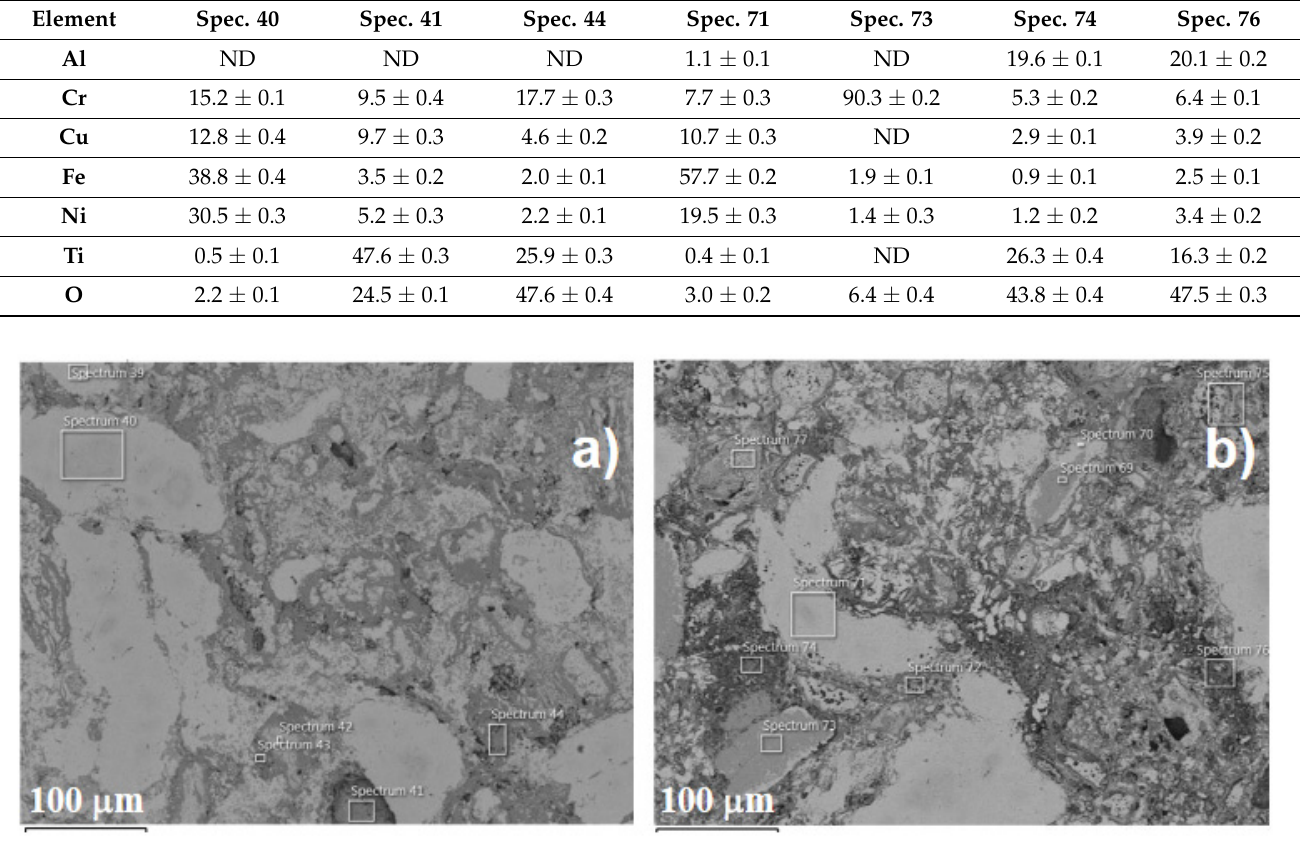
Figure 4. SEM-BSE micrographs and studied zones of x = 0 ( a ) and 5% ( b ) Al samples. Table 2. Summary chart with chemical analyses (in at. % & deviation) of spectrum shown in Figure 4 (ND = non-detected) .